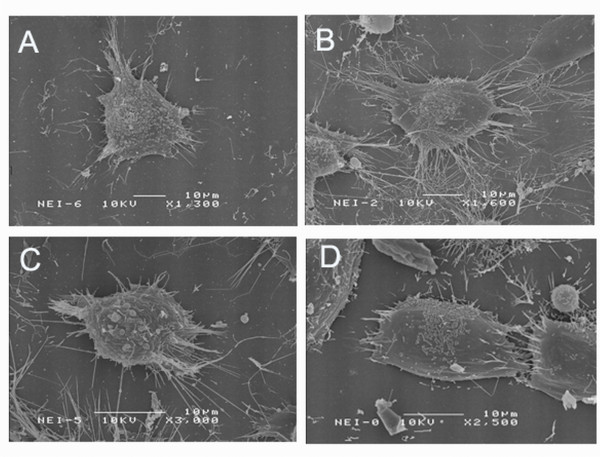
Scanning electron microscopy showed increased formation of membrane protrusions and microvilli in the Mia ez22-B cells (B) compared to that in the Mia pcb6 cells (A). A sharp decrease of the membrane protrusions and smooth edge in the Mia ezsi-E cells (D) compared to those in the Mia ezsi-scram cells (C).